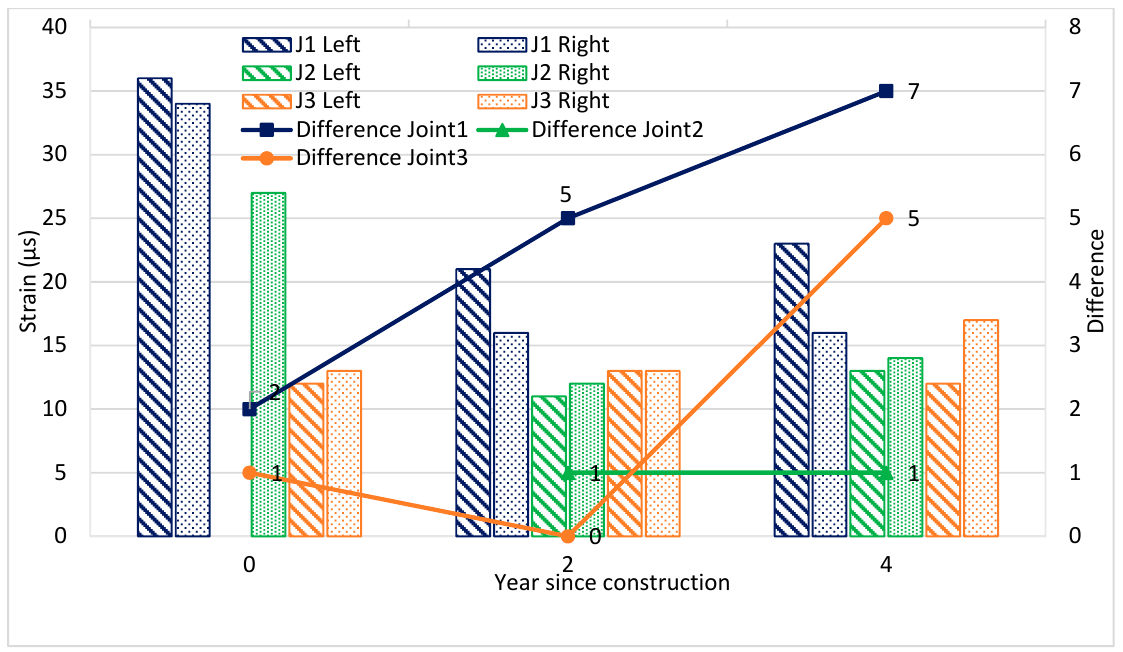
Figure 13. Strain data collected from left and right sides of each of three joints at 0, 2, and 4 years after construction.